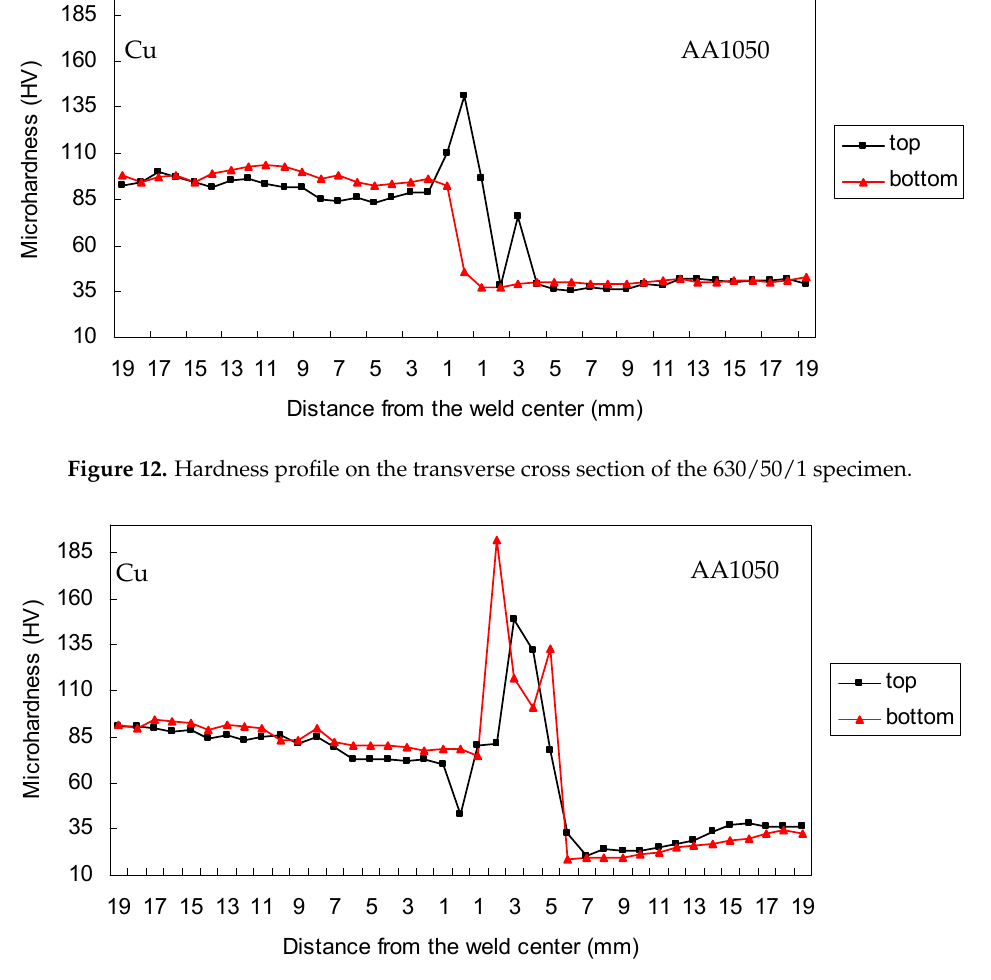
Figure 13. Hardness profile on the transverse cross section of the 1330/20/1 specimen.